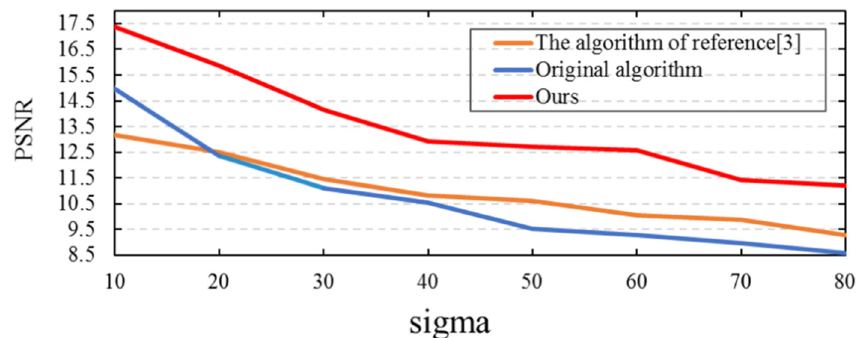
Figure 11. PSNR line chart of the three algorithms for the MIT image.